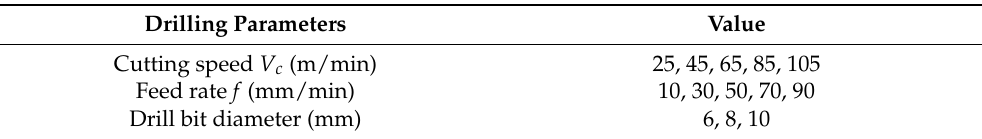
Table 1. Single factor experimental scheme of the influence of the cutting parameters on the thrust force and